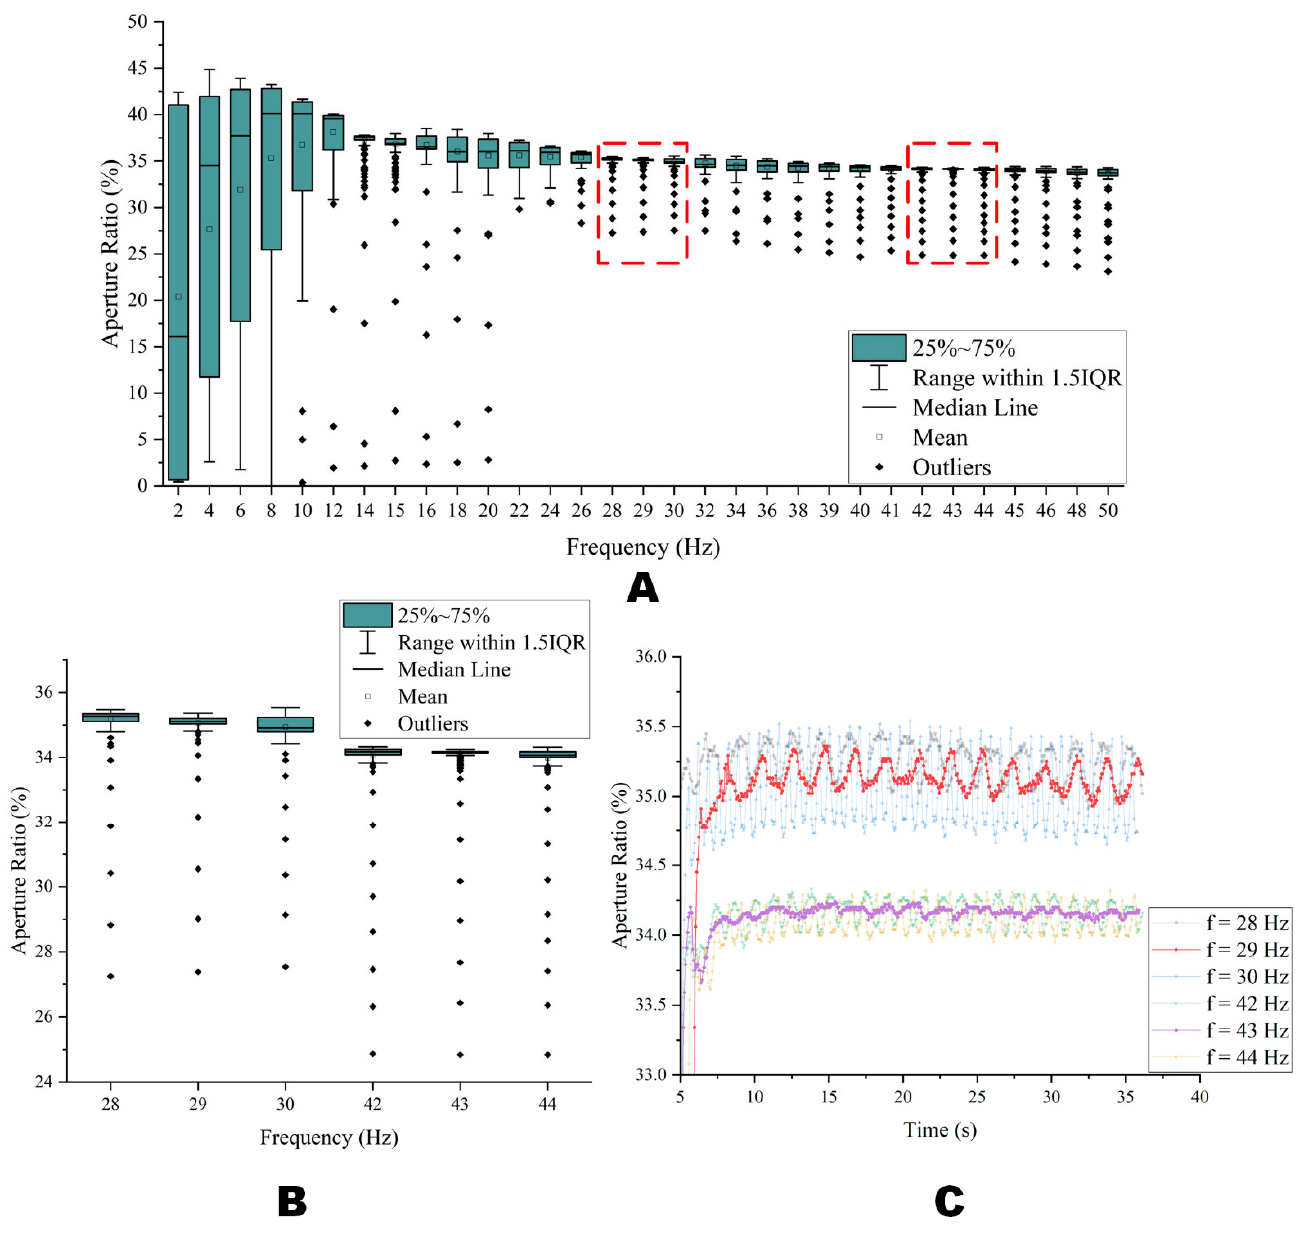
Figure 8. Fluctuations in EWD aperture ratio at different frequencies. ( A ) The EWD aperture ratio box diagram when V base = 20.5 V, t 2 = 11.63 ms, and the frequency was from 2 Hz to 50 Hz. ( B ) The aperture ratio box diagram at 28 Hz, 29 Hz, 30 Hz, 42 Hz, 43 Hz and 44 Hz when V base = 20.5 V, t 2 = 11.63 ms. ( C ) The aperture ratio and time relationship diagram at 28 Hz, 29 Hz, 30 Hz, 42 Hz, 43 Hz, and 44 Hz when V base = 20.5 V, t 2 = 11.63